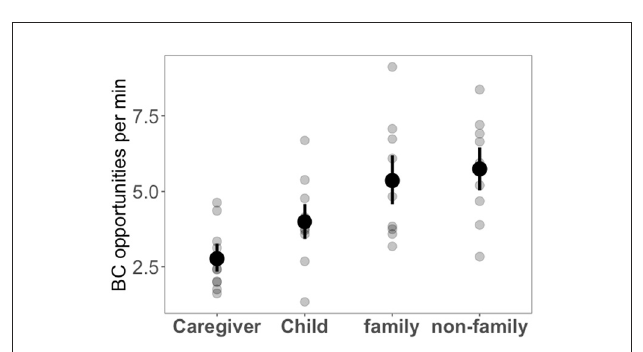
FIGURE6 The rate of BC (received) opportunities. Opportunities were defined roughly as pauses of at least 400 ms between two successive sound segments (or IPUs) of the